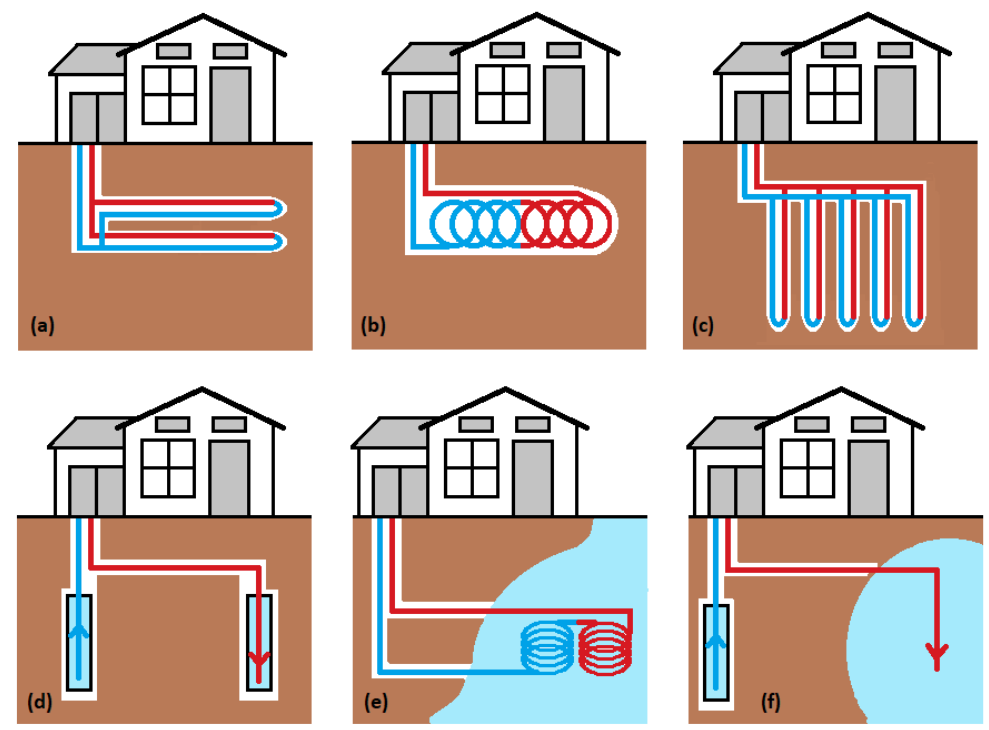
Figure 1. Different configurations of Ground Heat Exchanger: ( a ) closed horizontal loop, ( b ) closed slinky loop, ( c ) closed vertical loop, ( d ) open wells loop, ( e ) closed water loop and ( f ) open-circuit well and surface